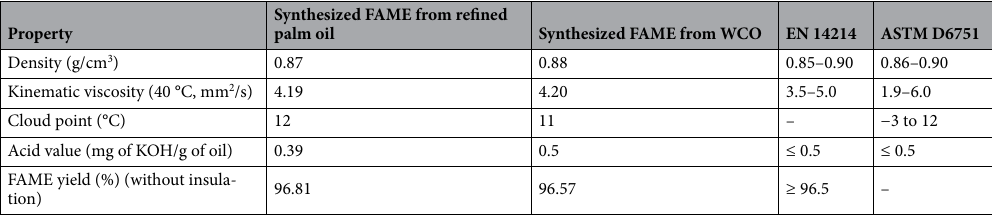
Table 1. Properties of produced